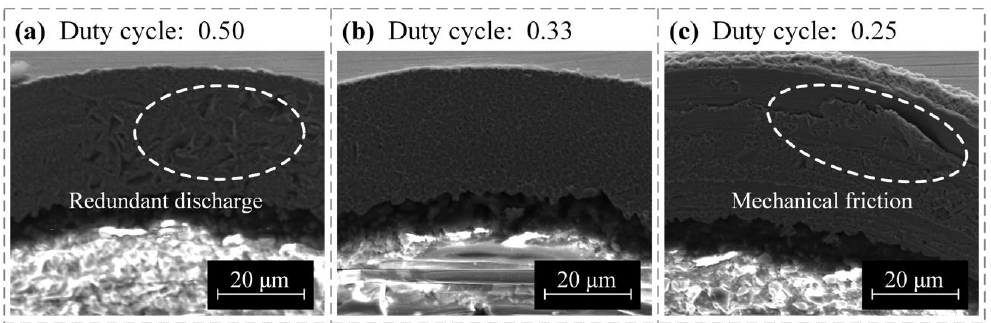
Figure 10. Influence of duty cycle on the machining quality of the interior wall of the micro-hole: ( a ) duty cycle was 0.50, ( b ) duty cycle was 0.33, and ( c ) duty cycle was 0.25.